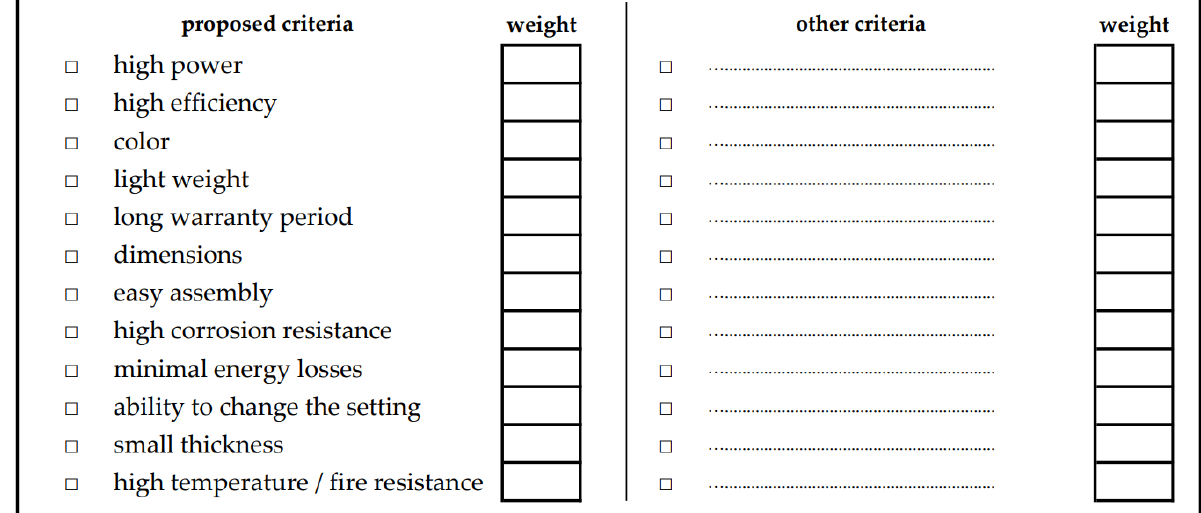
Figure 4. Example of questionnaire to obtain customer expectations in relation to photovoltaic panels criteria. Own study.